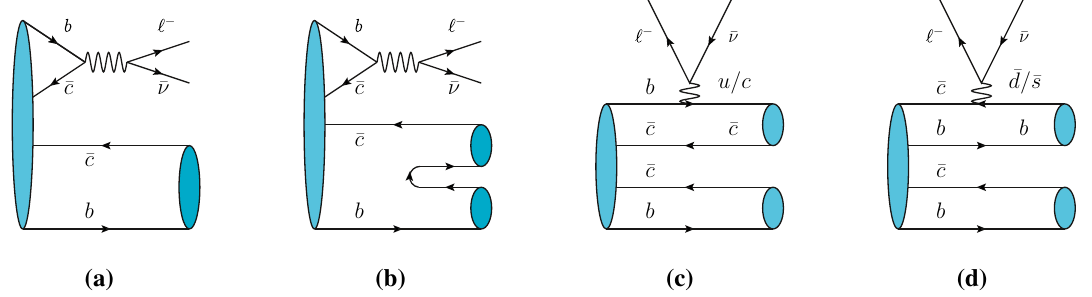
{ bb } / ¯ c quark decay. Panel a represents a meson final state, while the panel b – d Fig. 3 Feynman diagrams for T {¯ c ¯ c } semi-leptonic decays within b correspond with two mesons final states. In panel a , b , the quarks in initial state interact by the exchange of W boson